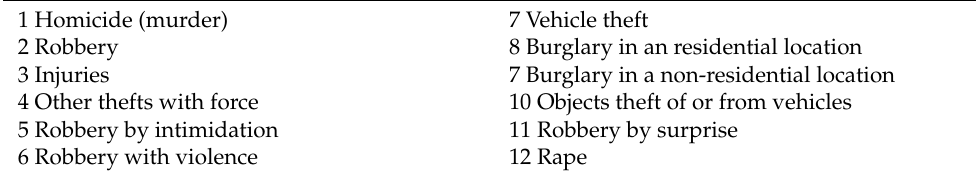
Table 1. Crimes collected in the database.